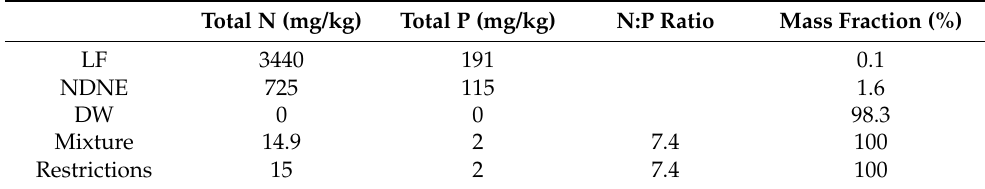
Table 1. The total N, total P and the N to P ratio of the LF, NDNE and DW, together with the calculated composition of the mixture after a non-linear solver technique maximising the NDNE composition within presented restrictions.